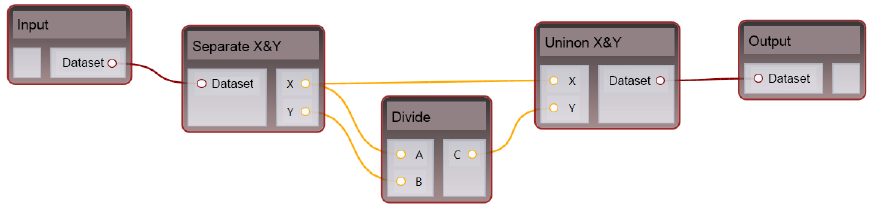
Fig. 6. CuPrUm visual script example.